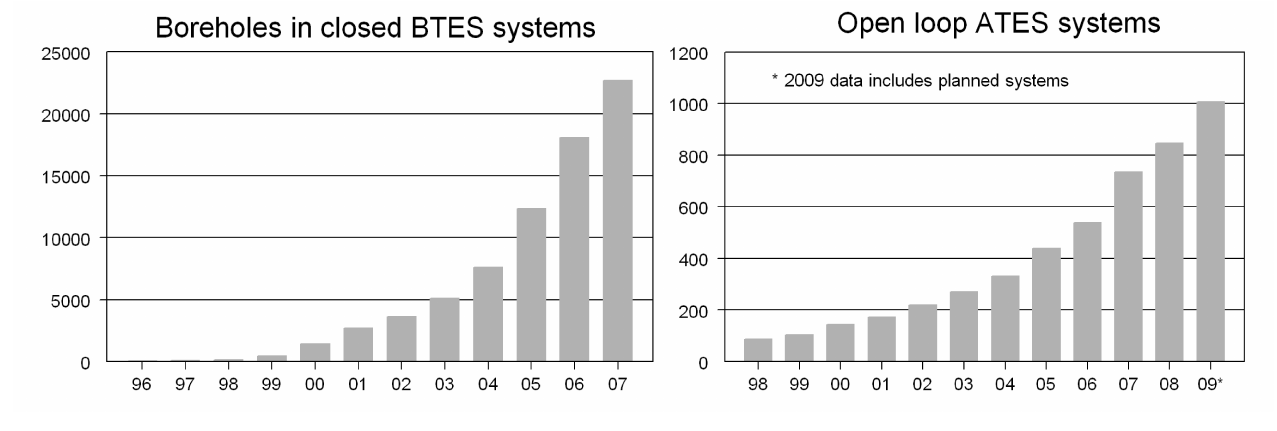
Fig. 1. Development of aquifer thermal energy storage (ATES) systems and borehole thermal energy system (BTES) wells in the Netherlands. ATES data were sourced from provincial authorities; BTES data are from Centraal Bureau voor de Statistiek